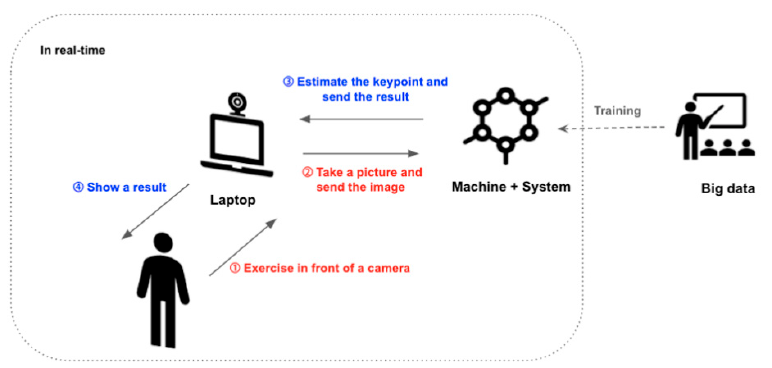
Figure 1. Scheme of the Weelo exercise